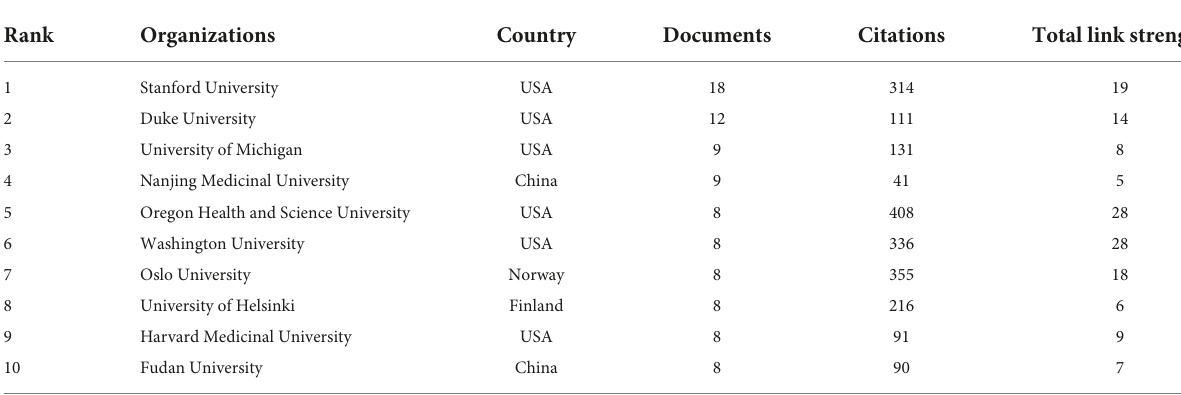
TABLE 1 Top 10 the most productive